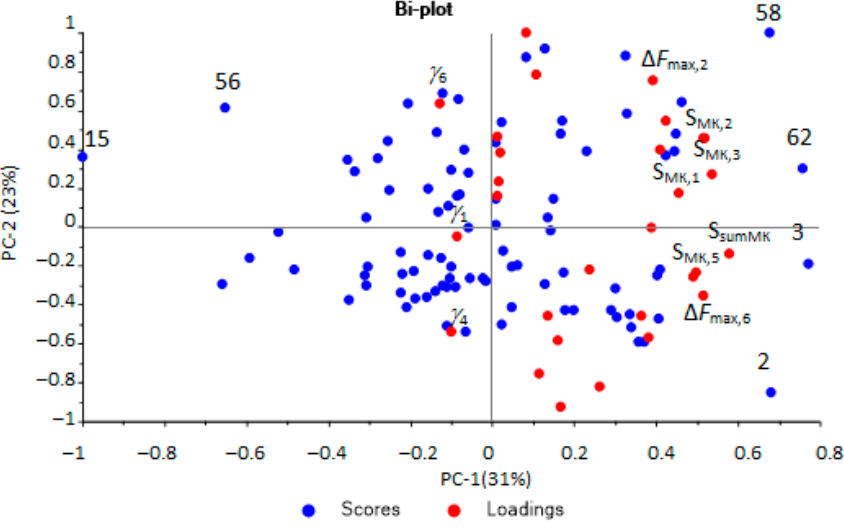
Figure 5. Scores and loadings plot of the PCA model for urine samples according to the optimal output data of the array of sensors (the plot with designation of all points in Supplementary Materials, Figure S7).